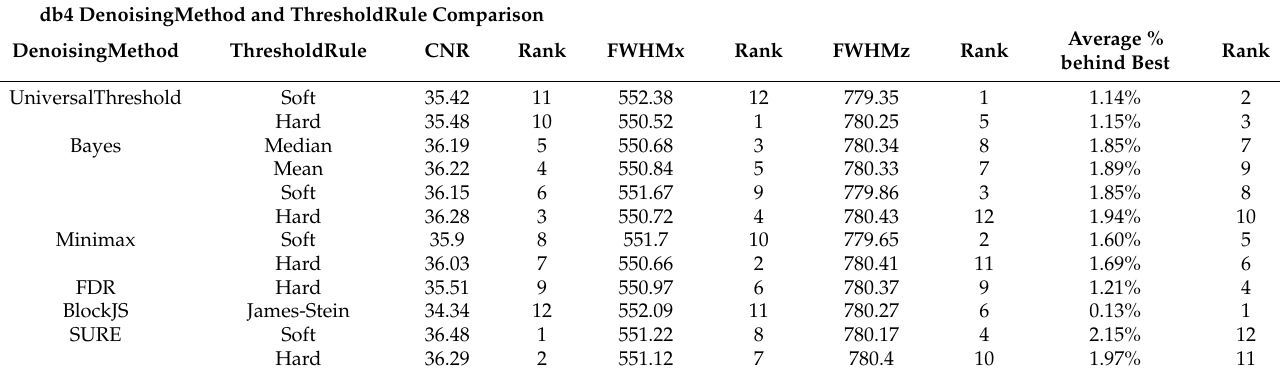
Table A2. Comparison of the permutations of “DenoisingMethod” and “ThresholdRule”. db4 DenoisingMethod and ThresholdRule Comparison